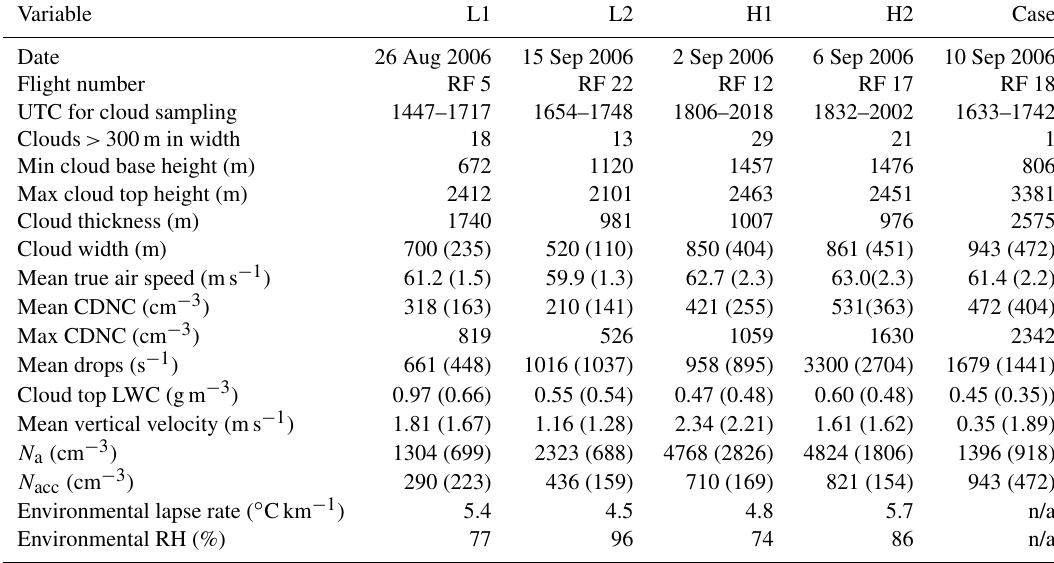
Table 2. A summary of cloud, flight, and environmental properties from the L1, L2, H1, H2, and case flights. Note that CDNC stands for cloud droplet number concentration, LWC stands for liquid water content, and mean drops (s − 1 ) represents the mean number of drops measured by the PDI per second. Standard deviation values are represented in parentheses.